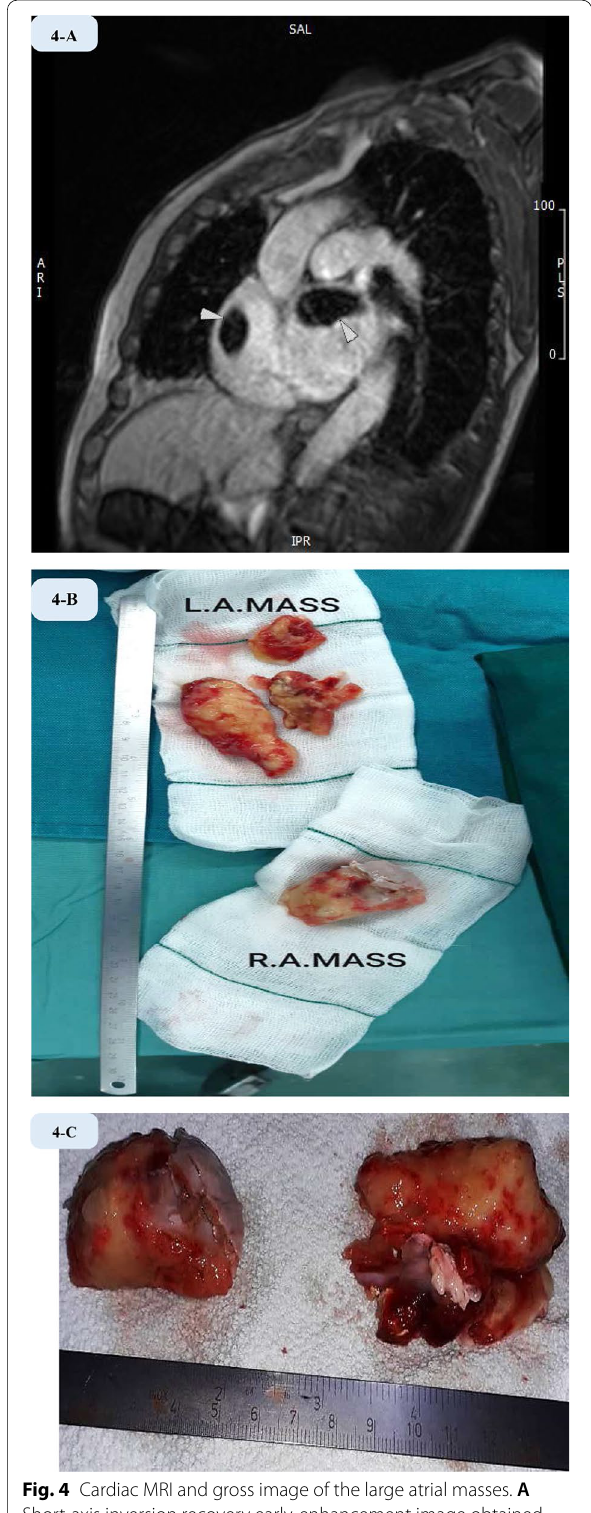
Fig. 4 Cardiac MRI and gross image of the large atrial masses. A Short‑axis inversion recovery early‑enhancement image obtained with inversion time of 600 ms and demonstrated two large clots within RAA and LAA (arrowheads) which are low signal (dark) on the image. B This montage shows the two atrial masses after surgical resection. C This image illustrates the main body of the two